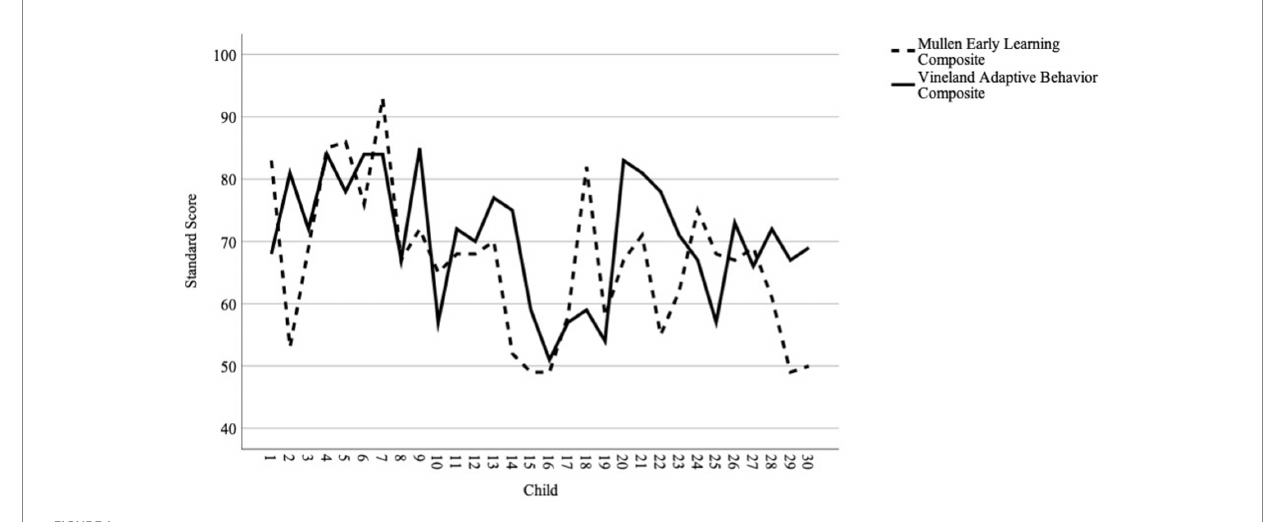
FIGURE 1 Plot of individual scores on the Vineland-ABC and